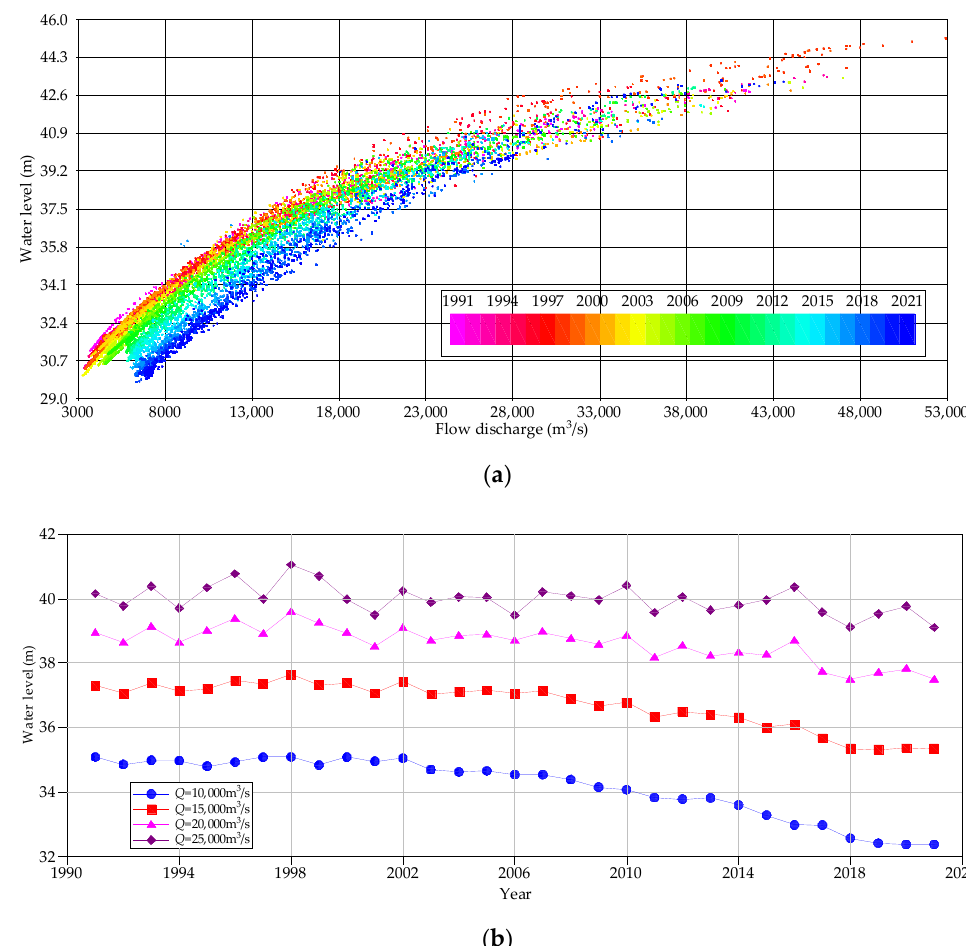
Figure 7. Variation in the water level at Shashi station. ( a ) Annual relationship between water level and flow discharge; ( b ) Water level changes since 1991 corresponding to typical flow discharge.